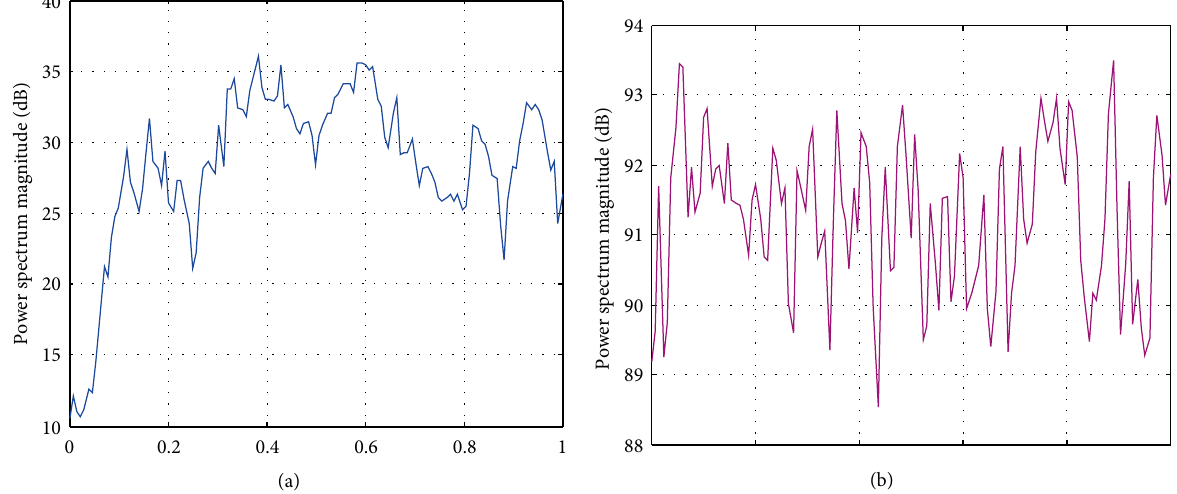
Figure 6: Power spectral density of (a) Original speech signal. (b) Encrypted speech signal.